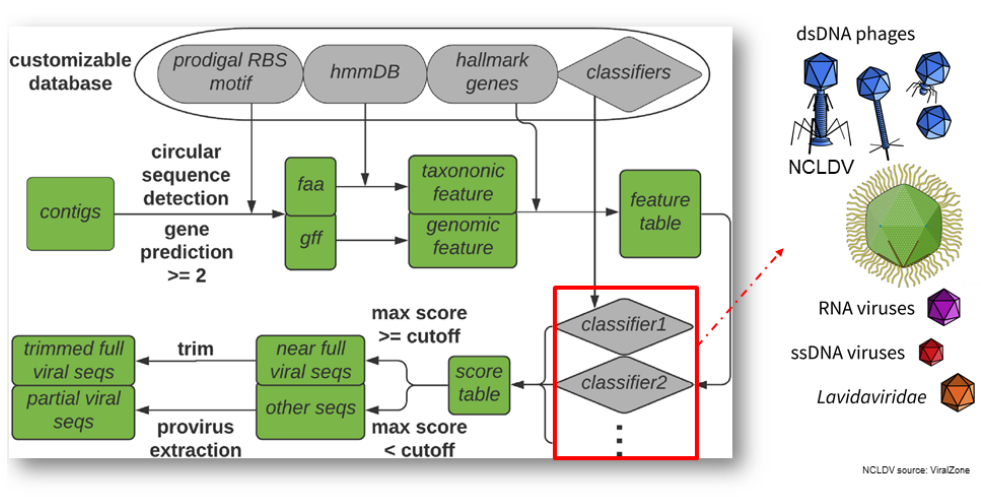
Figure 6. Overview of the viral sequence prediction pipeline used in VirSorter2 [40]. The “hmmDB” includes viral protein HMMs from two of the largest databases, VPF and Efam [38,42]. Distinct classifiers (random forest) are built for each of five major viral groups to improve accuracy on diverse viruses. Adapted with permission from [40] (https://creativecommons.org/licenses/by/4. 0/). Copyright 2021, Guo et